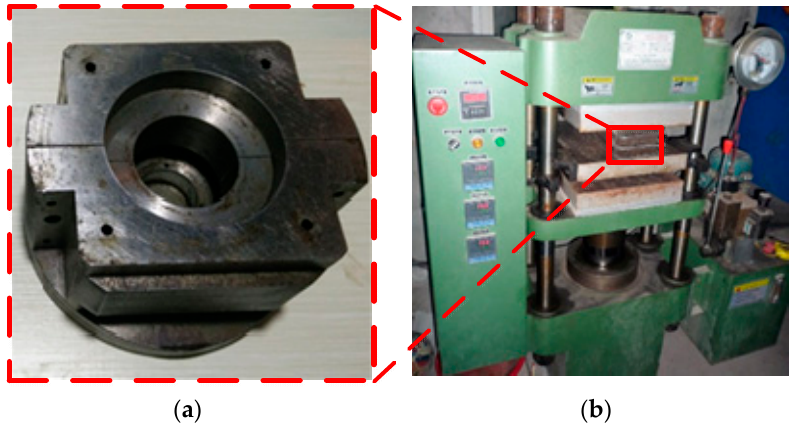
Figure 2. Vulcanization process of viscoelastic damper: ( a ) mold. ( b ) Flat vulcanizing machine. As shown in Figure 3, the cylindrical viscoelastic damper is composed of an inner aluminum cylinder, an outer aluminum cylinder, and a viscoelastic layer bonded by vulcanization between the inner and outer cylinders. The viscoelastic layer is 50 mm in height, 5 mm in thickness, 46 mm in the outer diameter, 36 mm in the inner diameter, and 6437 mm 2 in a shear area. In practical application, the inner aluminum tube and the outer aluminum tube of the damper will be, respectively, installed between the base of the isolation structure and the damping components. The relative displacement between the inner and outer tubes will lead to the shear deformation of the viscoelastic layer, which plays the role of energy dissipation and vibration